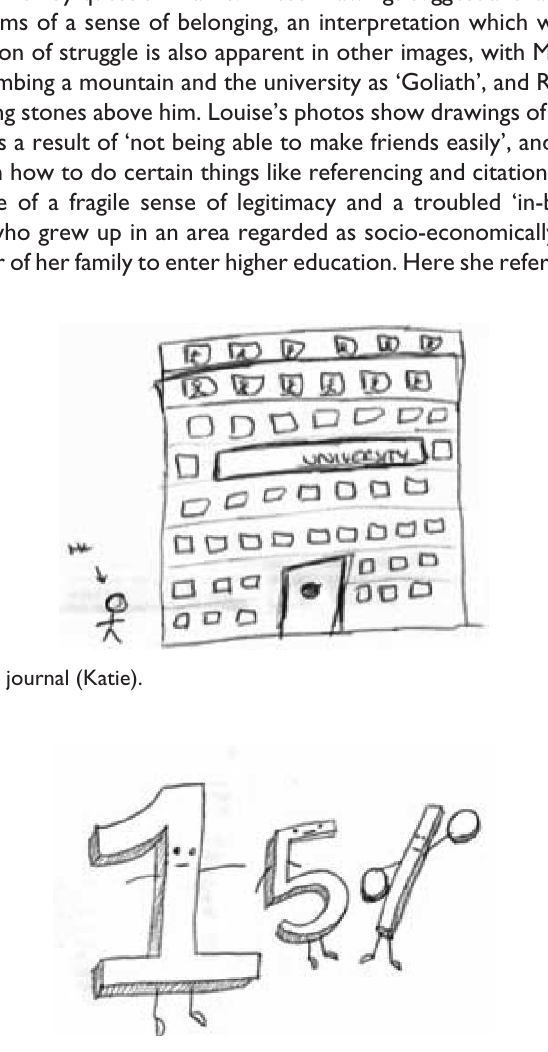
Figure 2. Image from journal (Lisa).